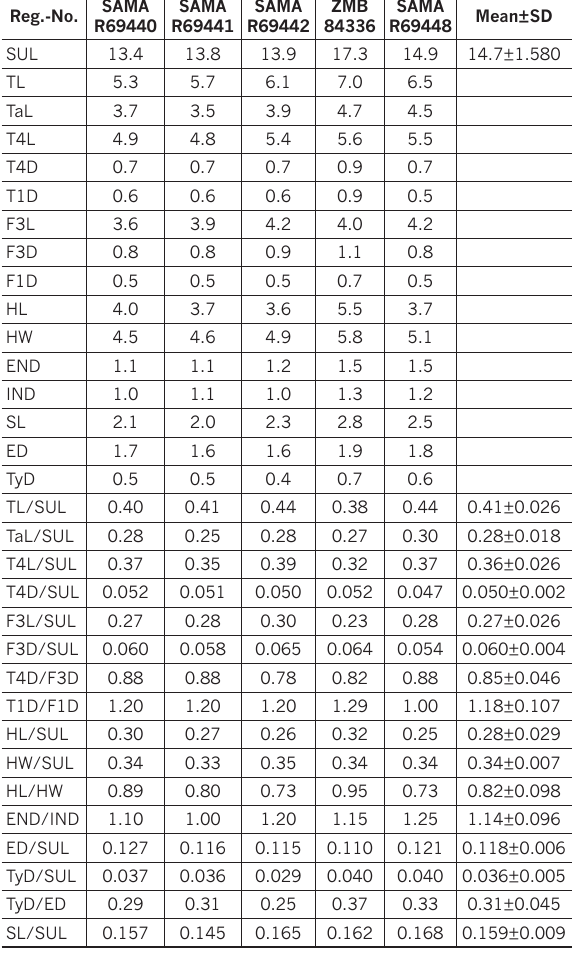
Table 1. Body measurements and body ratios of the type se- ries of Choerophryne crucifer sp. n. SAMA R69448 is the ho- lotype, all five types are adult males; all measurements in mm. Reg.-No = Registration number; SD = standard deviation; for explanations of abbreviations for measurements see “Material and methods”.